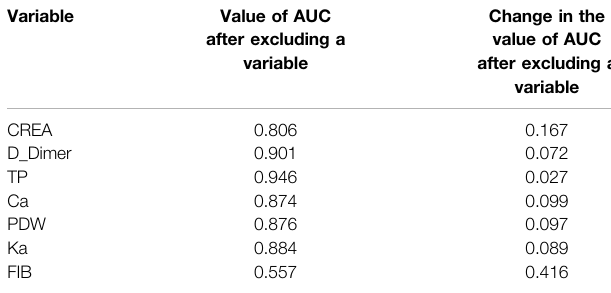
TABLE 3 | Change in the AUC values when each variable is excluded from the